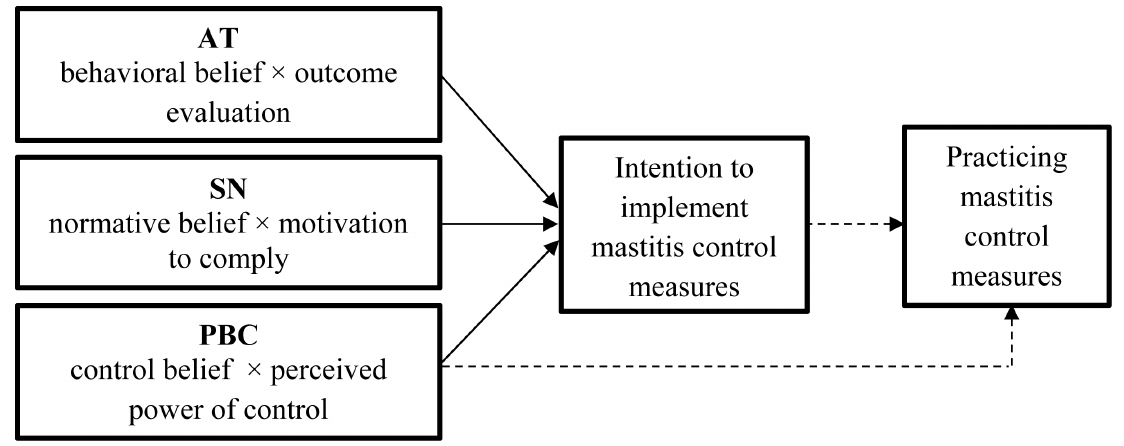
Fig 1. Framework of the theory of planned behavior model as applied in the performed analyseson the intention to participate in mastitis control measures(adapted from Ajzen [35]). AT = Attitude, SN = Subjective norm, PBC = Perceived behavioralcontrol. Dotted lines indicate associations that are not studiedin this